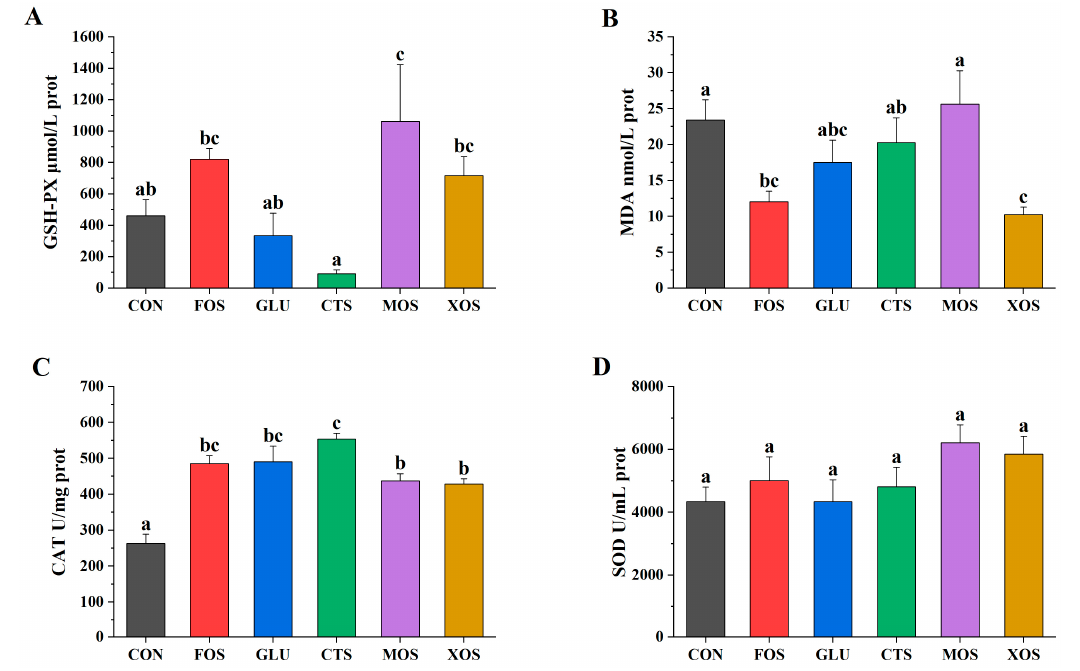
Figure 2. Effects of different prebiotics on antioxidant activities of hybrid grouper. ( A ) GSH-PX, ( B ) MDA, ( C ) CAT, and ( D ) SOD. Values are expressed as means ± SEM; Mean values in the same row with different superscript letters are significantly different ( p < 0.05); CON, control; FOS, fructooligosaccharides; GLU, β -glucan; CTS, chitosan; MOS, mannan-oligosaccharides; XOS, xylooligosaccharides; SE, standard error of the mean.